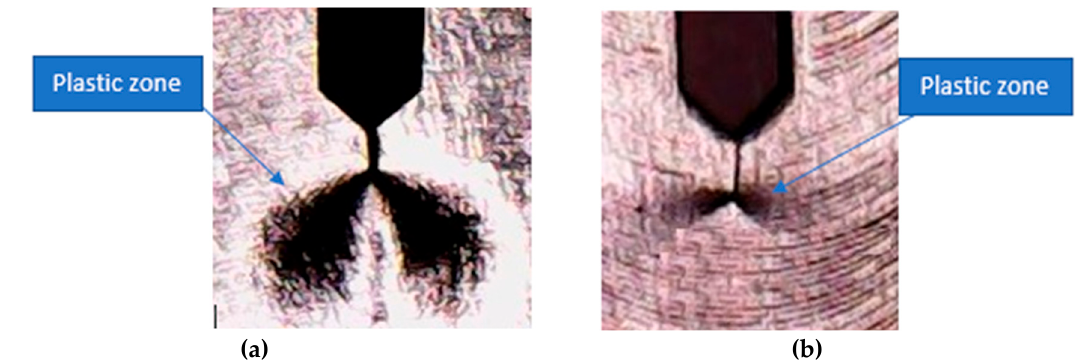
Table 5. Influence of FSP on the fracture toughness of 2507 SDSS.